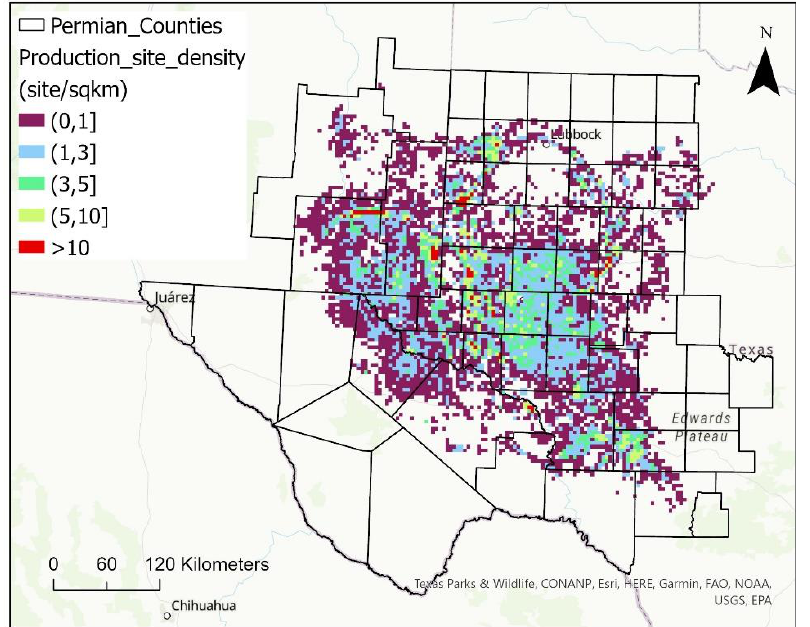
Figure 3. Production site densities in the Permian Basin, with production sites aggregated into 4 × 4 km 2 grid cells.